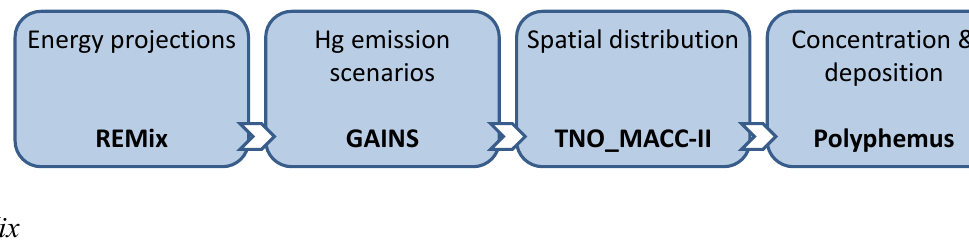
Figure 1. Data flow between models used for the mercury